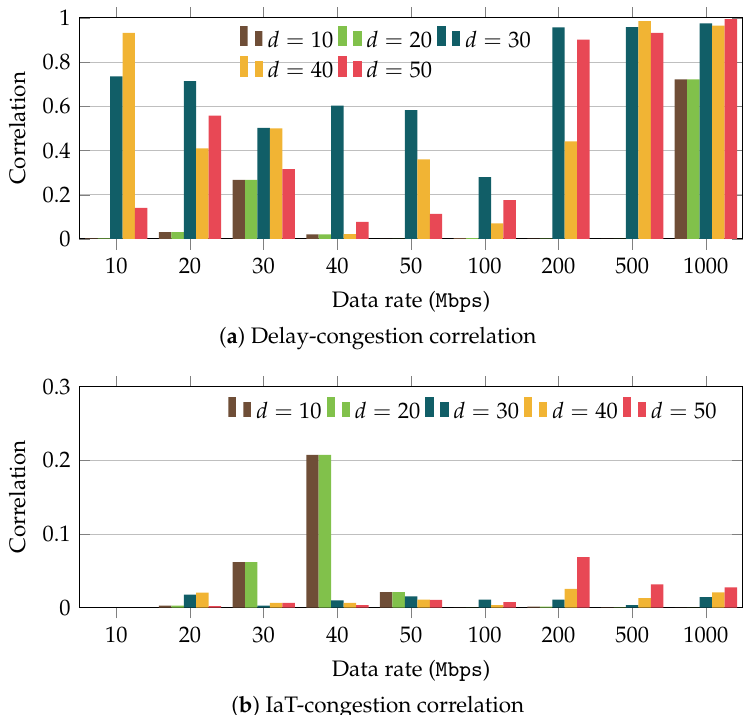
Linear correlation between the RLC buffer and transport level metrics using the max-weight